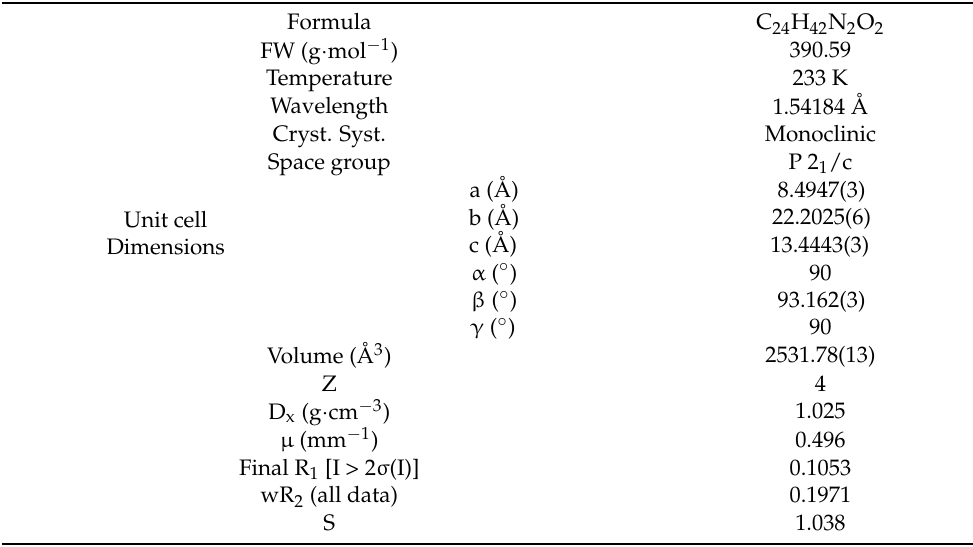
Table 1. Crystal data and structure refinement for the Lido: DL M cocrystal recorded at 233 K (Cam- bridge Crystallographic Data Centre reference number: